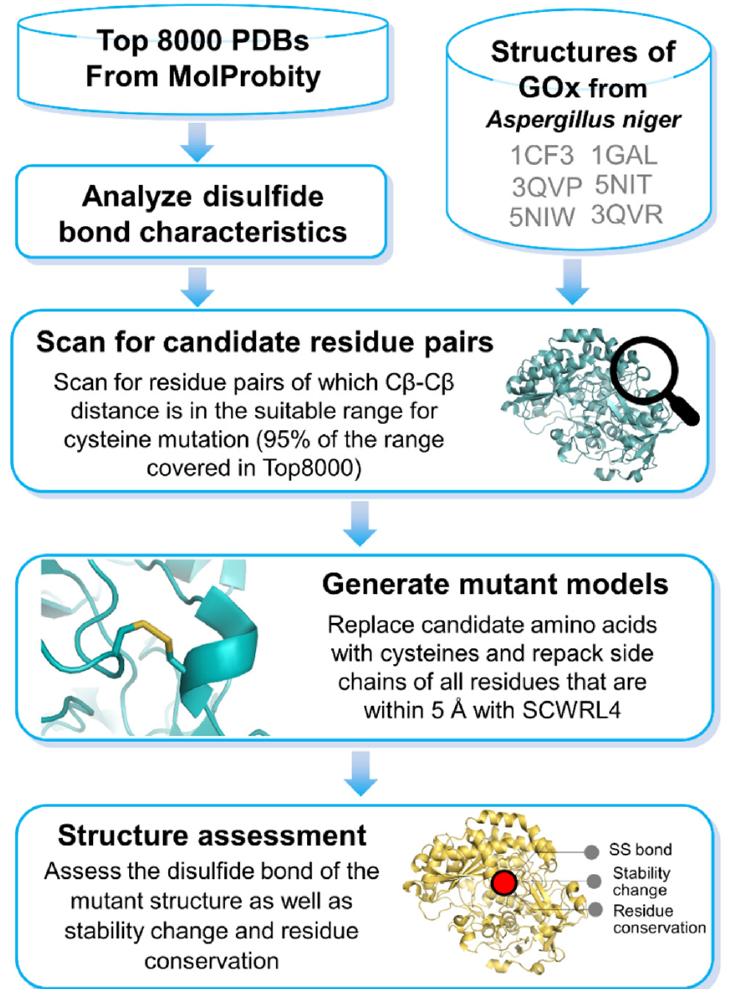
Figure 1. Conceptual illustration of the pipeline to realize rational bioengineering designs of GOx for optimizing protein stability.